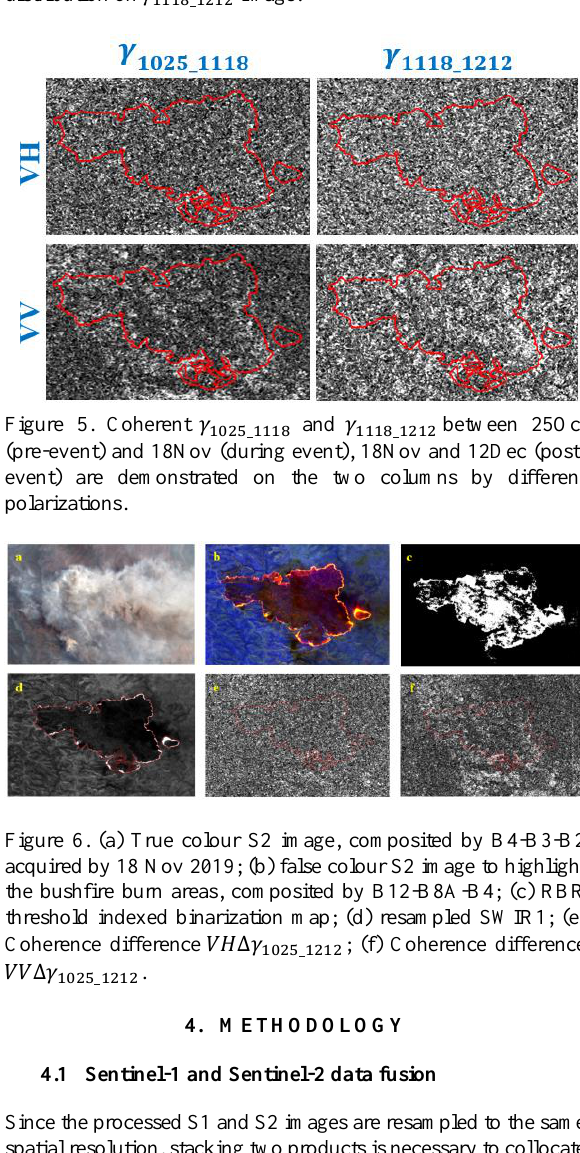
Figure 8. An example of morphological closing operation (right) on original image